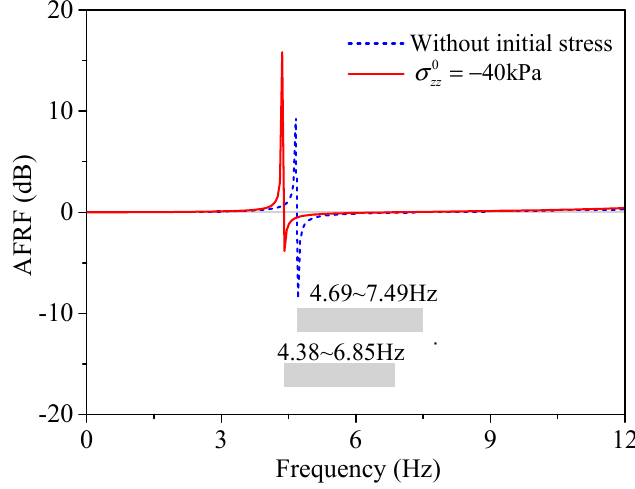
Figure 10. AFRFs of the five-unit-cell periodic foundation under P waves.